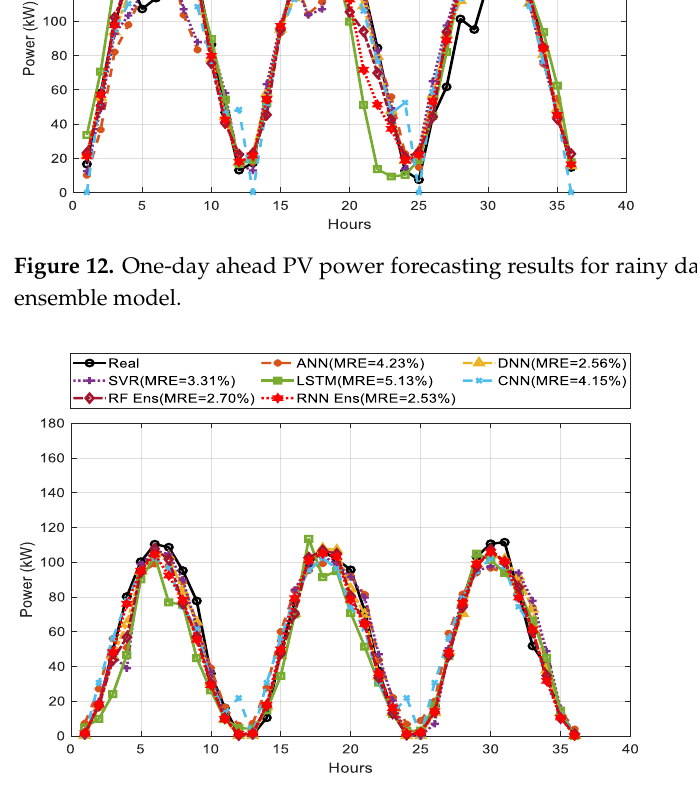
Figure 13. Three-day ahead PV power forecasting results for sunny days between single model and Figure 14. Three-day ahead PV power forecasting results for cloudy days between single model Figure 14. Three-day ahead PV power forecasting results for cloudy days between single model Figure 14. Three-day ahead PV power forecasting results for cloudy days between single model ensemble model. and ensemble model. and ensemble model. and ensemble model.